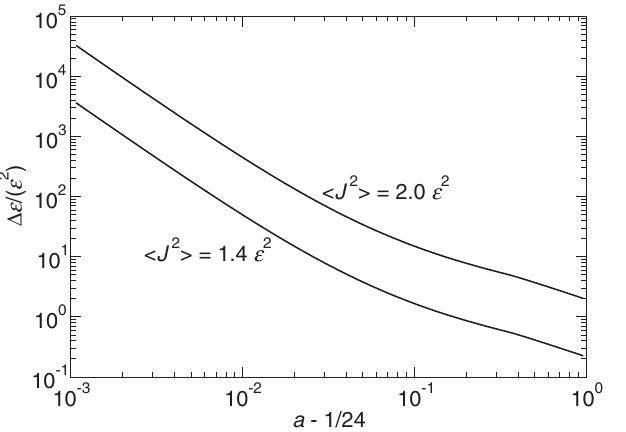
FIG. 6. Emittance growth as a function of b for various values for a